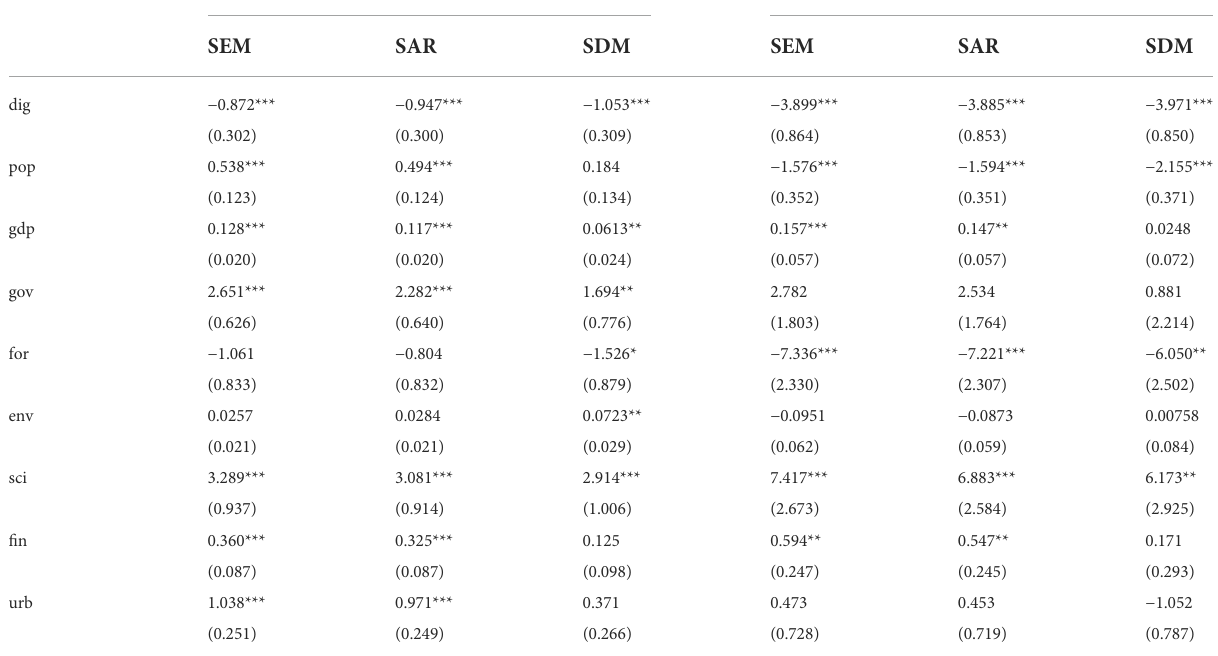
TABLE 7 Robustness